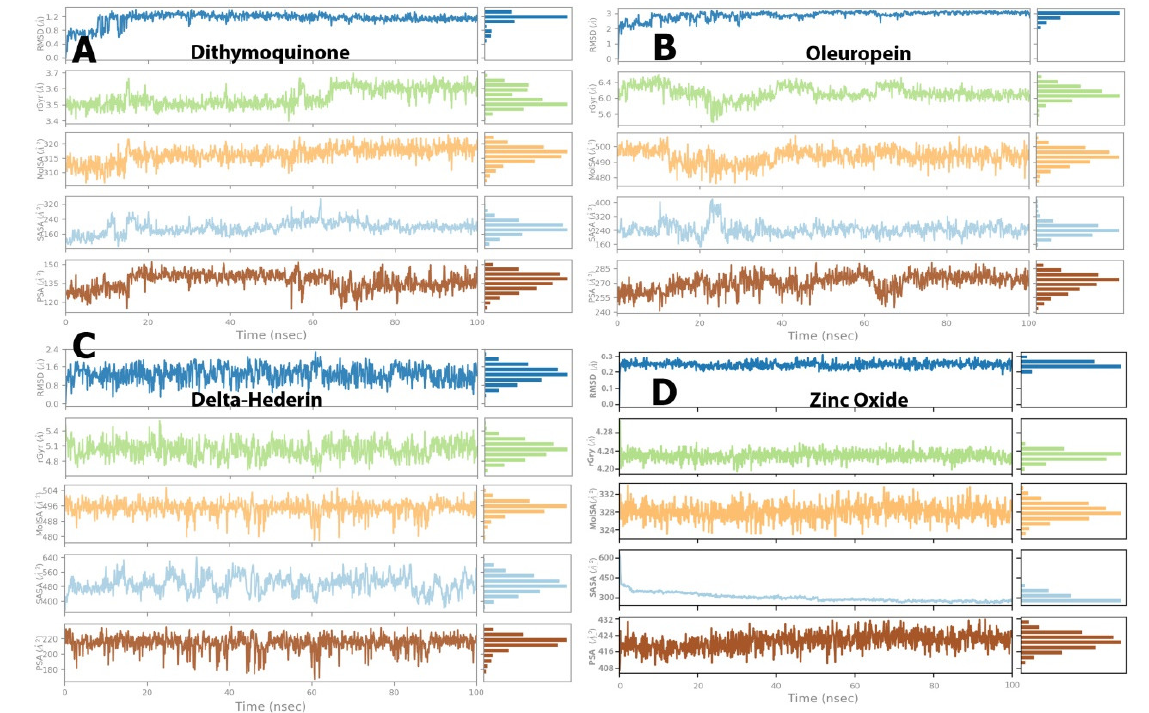
Figure 6. Post-molecular dynamics simulation analysis of protein and ligand properties, radius of gyration (rGyr), molecular surface area (MolSA), solvent accessible surface area (SASA) and polar surface area (PSA). ( A ) dithymoquinone, ( B ) oleuropein, ( C ) delta-hederin, ( D ) zinc oxide.